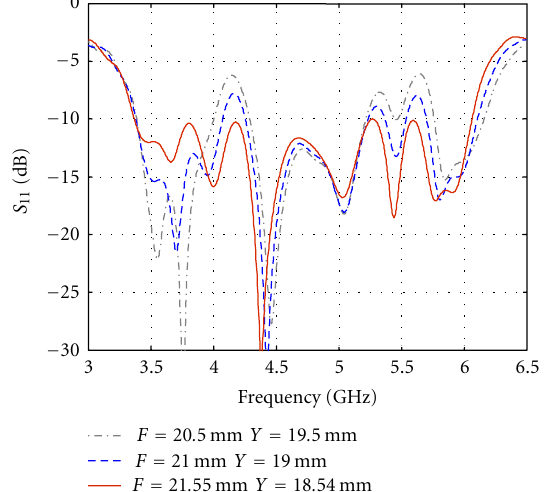
Figure 3: Reflection coe ffi cient of the MSA-BP for di ff erent ( F , Y ) couples.